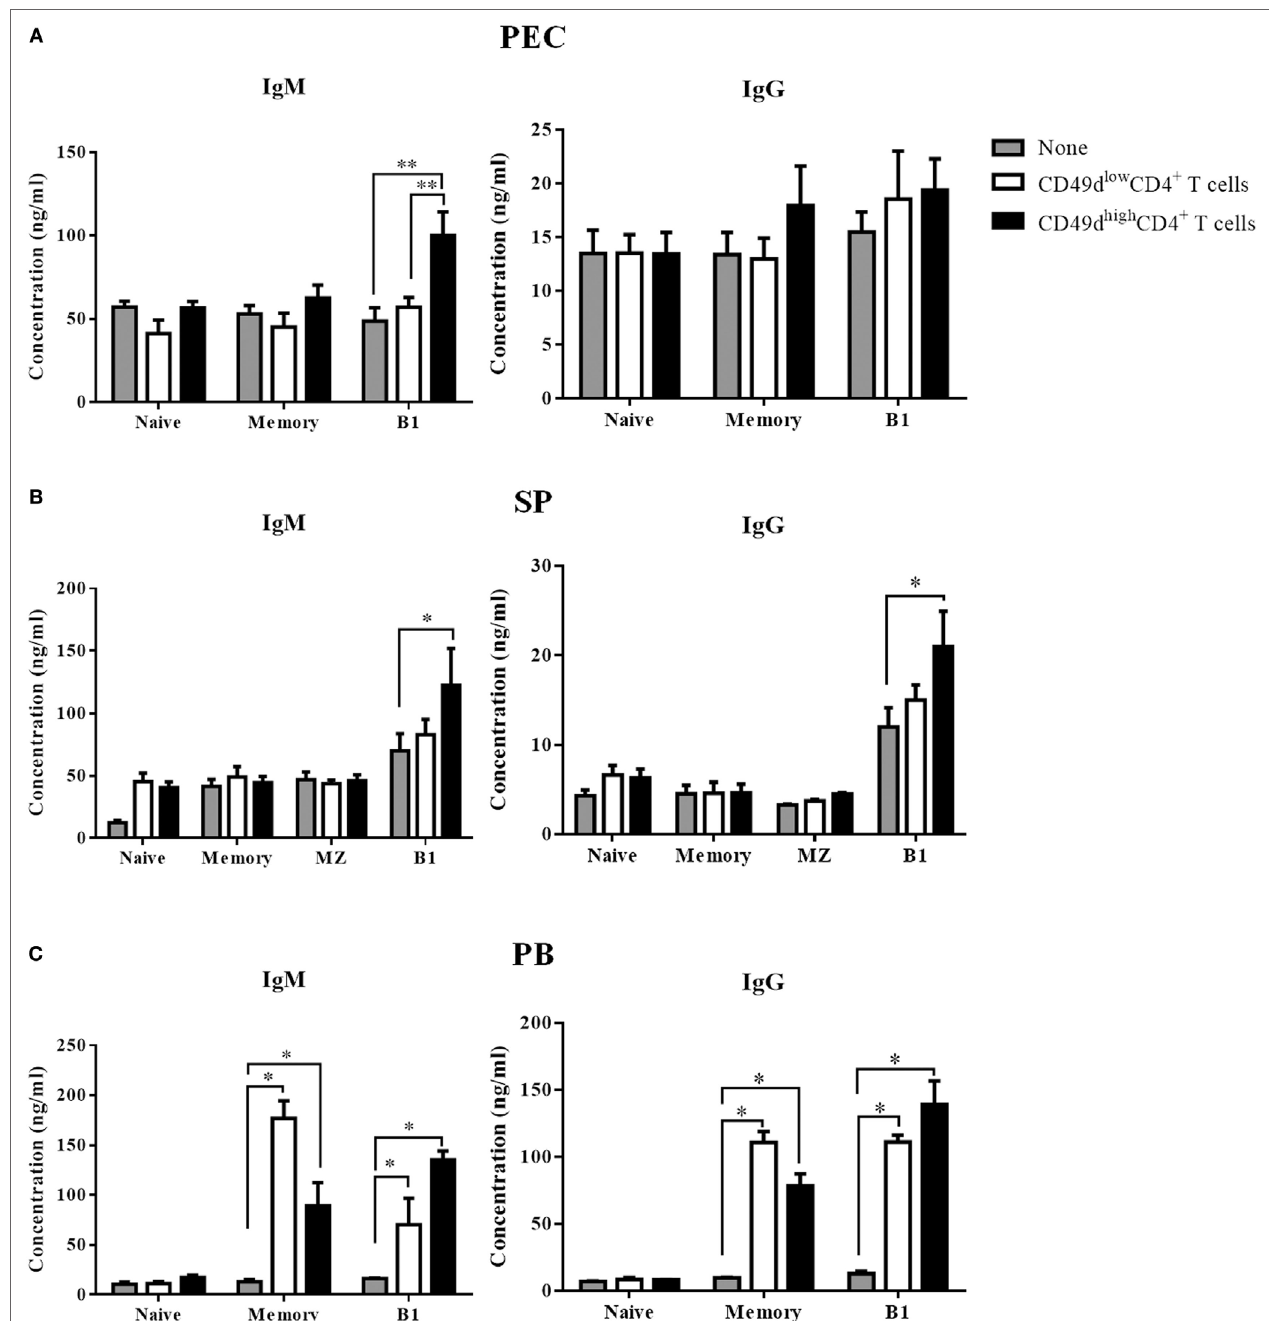
FigUre 5 | CD49d high CD4 + T cells help immunoglobulin secretion by human B-1 cells. (a) Sorted peritoneal, (B) splenic, and (c) PB-derived CD49d high CD4 + T cells or CD49d low CD4 + T cells were co-cultured with sorted naïve (CD20 + CD27 − CD43 − CD1c − ), memory (CD20 + CD27 + CD43 − CD1c − ), marginal zone (CD20 + CD27 + CD43 − CD1c + ), and B-1 (CD20 + CD27 + CD43 + CD1c − ) B cells for 5 days in the presence of immobilized anti-CD3 antibody. Concentrations of human IgM and IgG in the culture supernatant were compared among the B cell alone group (gray), the CD49d high CD4 + T cell group (black), and the CD49d low CD4 + T cell group (white). Data are expressed as the mean ± SEM ( n = 3–5 donors per each group). * P < 0.05, ** P < 0.01; Student’s t -test. Abbreviations: PEC, peritoneal cavity; SP, spleen; PB, peripheral